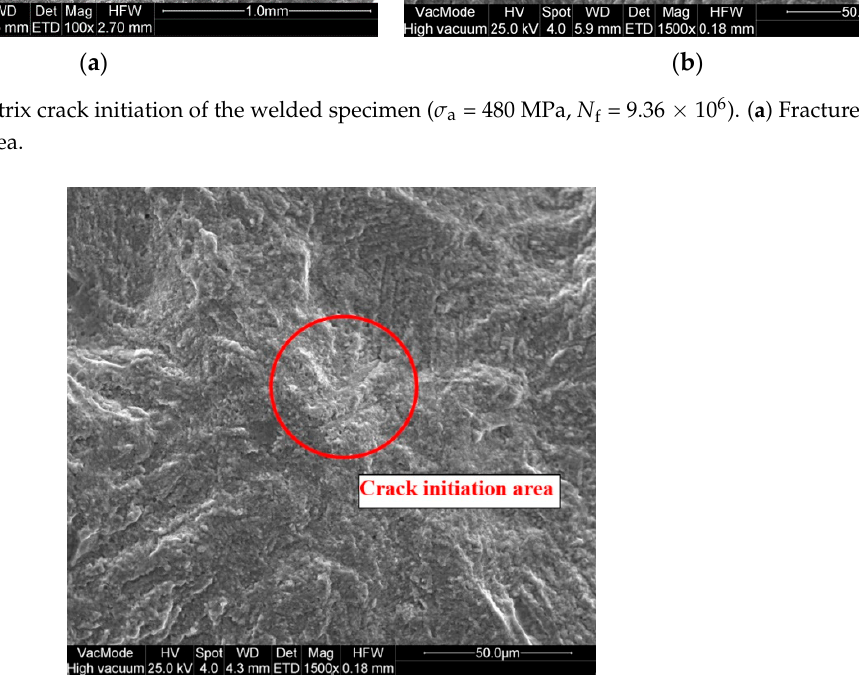
7 a = 500 MPa, N f = 1.09 × 10